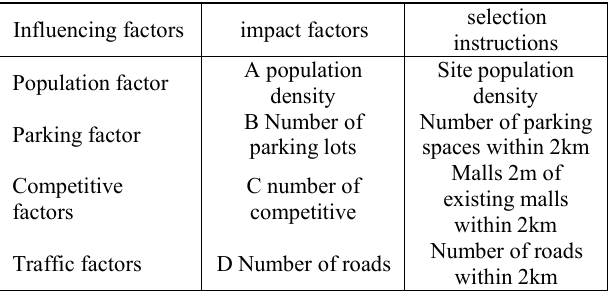
Table 1. Influencing factors and selection of large-scale